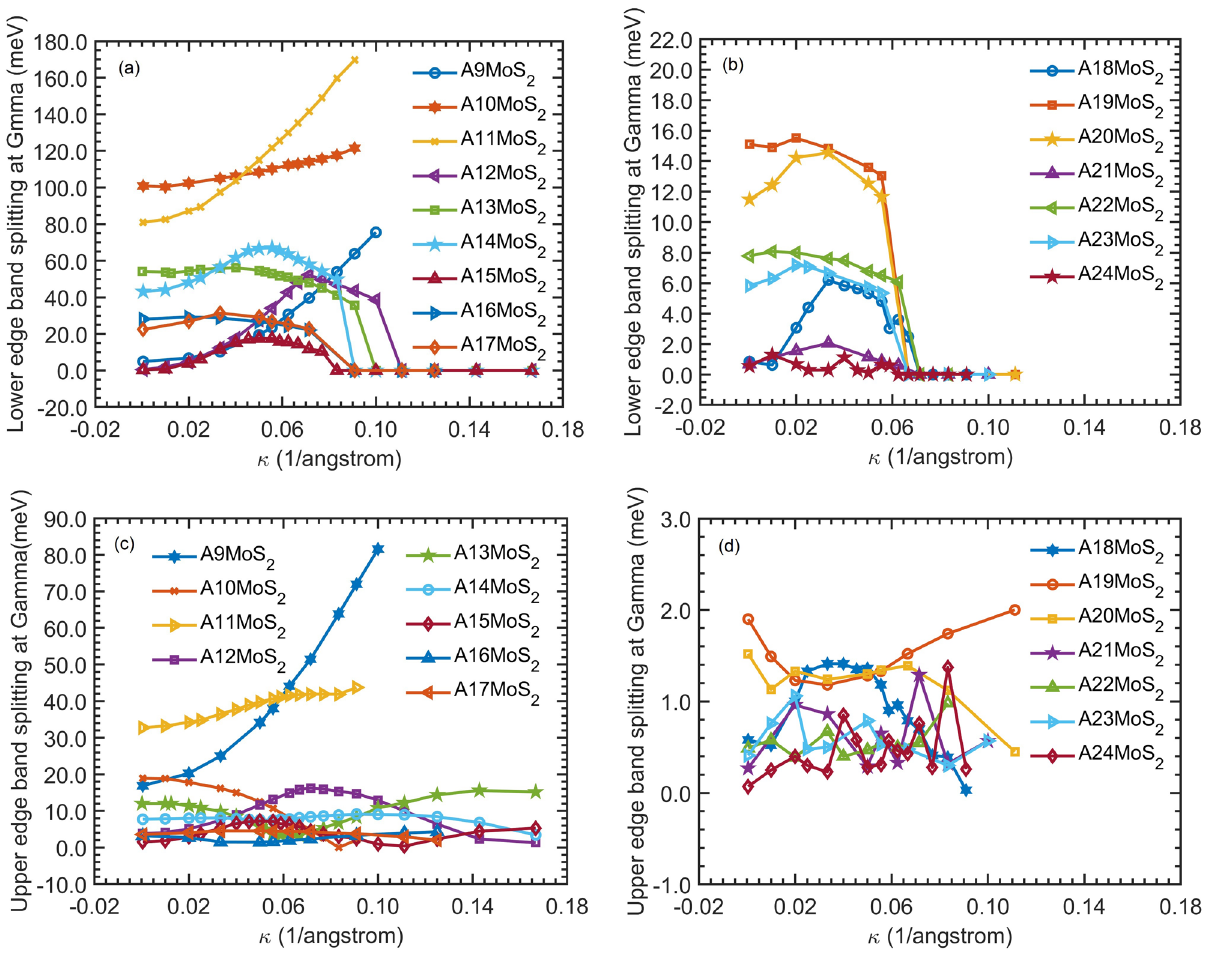
Figure 4. The nondegenerate splitting of the lower edge band gap ( (cid:31) E V ) and the upper edge band gap ( (cid:31) E C ) of A n MoS 2 nanoribbons as a function of bending curvature κ calculated from SCAN for different nanoribbon width n . The lower edge band gap splitting is in ( a ) n from 9 to 17 and ( b ) n from 18 to 24. The upper edge gap splitting is in ( c ) n from 9 to 17 and ( d ) n from 18 to